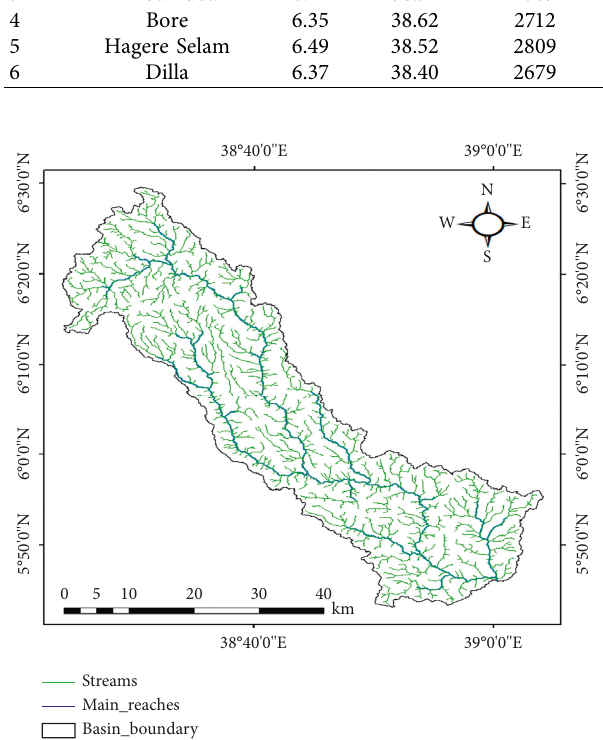
Figure 3: Streamflow network of the middle Awata watershed.